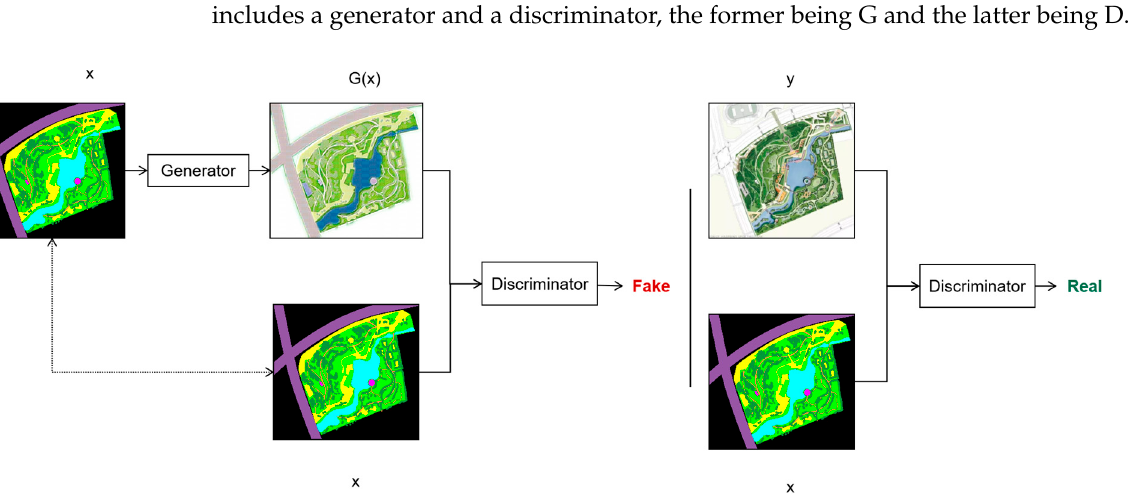
Figure 4. The overall framework of pix2pix.